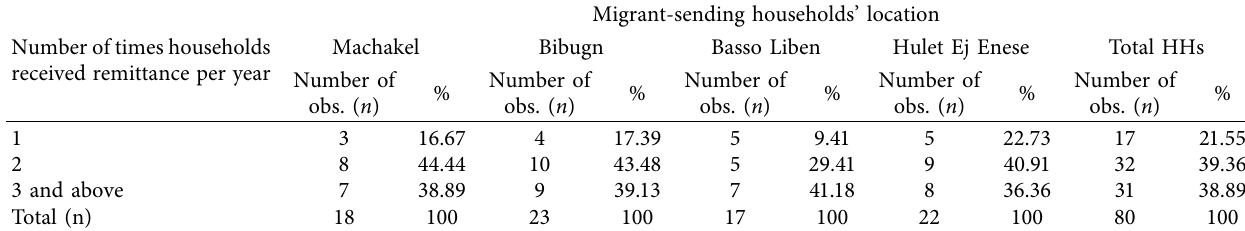
Table 1: Frequency of